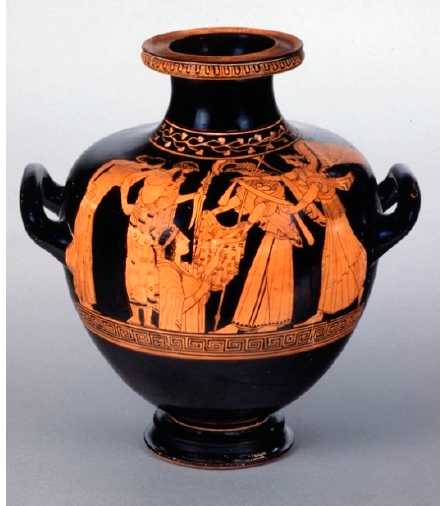
Figure 5. The Birth of Erichthonios (BM acc. no. 1837,0609.54); red-figure hydria; attr. to the Oinanthe Painter; Attica (from Chiusi); ca. 460 BCE . [© The Trustees of the British Museum, image made available through a CC BY-NS-SA 4.0 license].